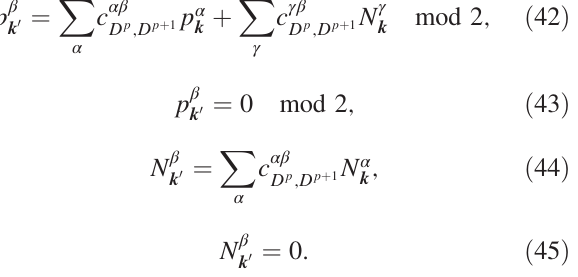
FIG. 8. Illustration of the physical process of d p; 0 1 . (a) For a given set of the zero-dimensional topological invariants at 0-cells, d 0 ; 0 1 determines whether gapless points should exist on the adjacent 1-cells. In the figure, we focus on two 0-cells (denoted by k 1 and k 2 ) and the 1-cell connecting k 1 to k 2 . (b) For gapless points on 1-cells, d 1 ; 0 1 tells us whether the gapless points should be extended to the adjacent 2-cells. In the figure, we discuss two 2-cells adjacent to the 1-cell D 1 and illustrate the case where the gapless points are